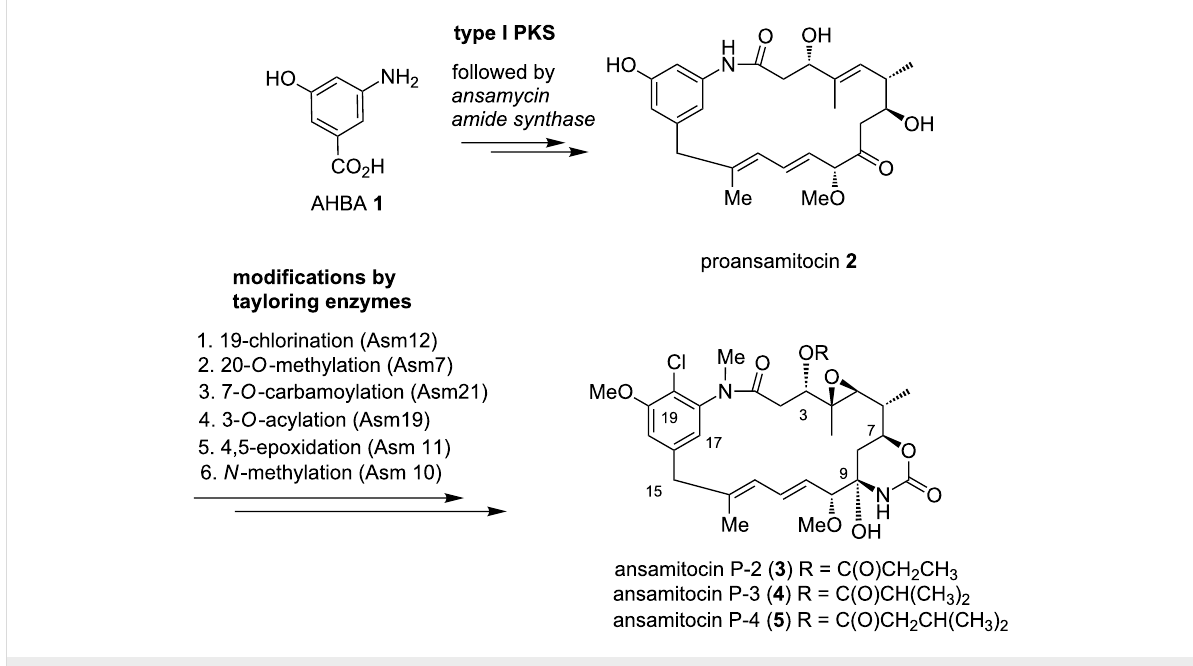
Scheme 1: Short representation of ansamitocin